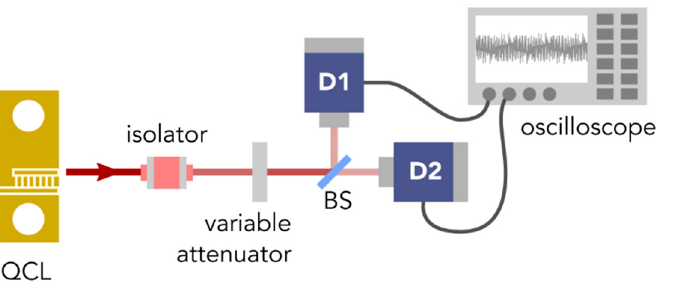
Figure 7. Sketch of the BHD characterization setup. A single-mode QCL is used as a local oscillator (LO) and sent on a BHD made of a 50/50 beam splitter (BS) and two HgCdTe photovoltaic detectors. After a preamplification stage, the detector output AC signals are acquired in the time domain, using an oscilloscope. To avoid any detector power saturation, a variable attenuator is used to control the incident laser power. Reprinted with permission from [77], copyright © The Optical Society 2021.